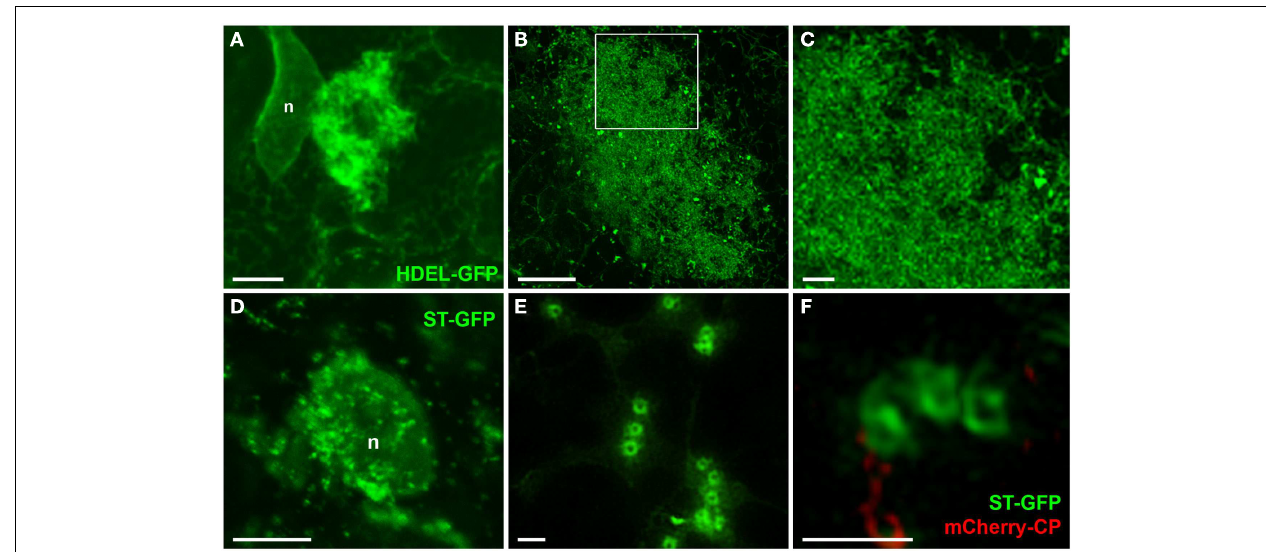
hoops similar to those labeled by theTGB2 andTGB3 proteins. (D) Confocal image of Golgi stacks labeled with ST-GFP (Boevink et al., 1998) recruited to a nascent X-body of a PVX-infected, fixed cell. (E,F) , Super-resolution images of Golgi stacks in cells infected with PVX.mCherry-CP [not shown in (E) ] resolve the trans-Golgi as a membrane circle with a larger diameter than the TGB2/3-containing ER hoops [note (C,E) have almost identical scales]. Bars (A,B) : 5 µ m; (C) : 1 µ m; (D) : 10 µ m; (E,F) : 1 µ